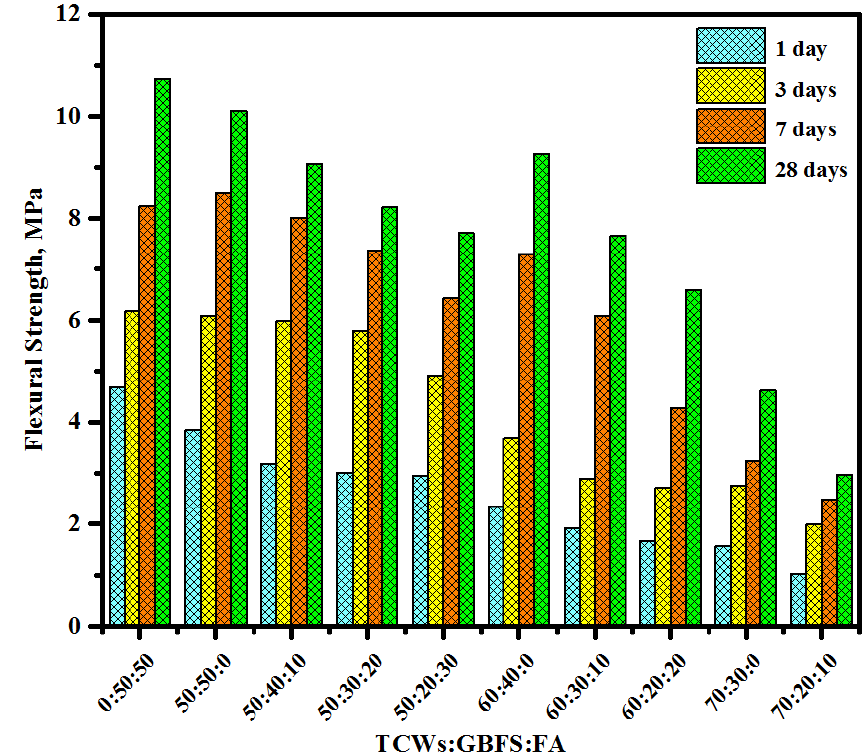
Figure 7. Flexural strength of GPMs for high volume TCWs content at 28 days of age.